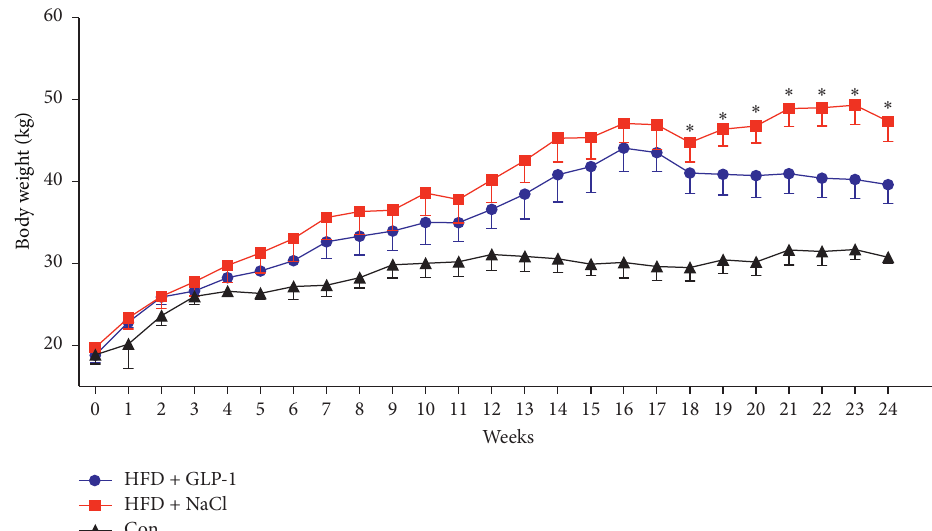
Figure 1: Comparison of body weight in each group. Group A: HFD+GLP-1; Group B: HFD+0.9% NaCl; Group C: Con. ∗ P < 0.05 vs. Group